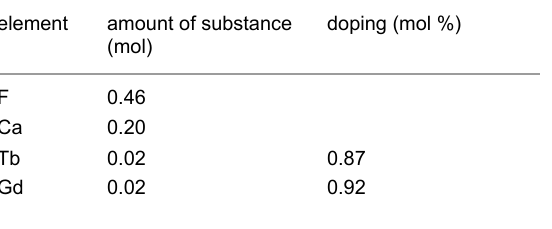
Table 1: Representative outcome of an ICP-OES measurement of CaF 2 :(Tb 3+ ,Gd 3+ ) NPs.